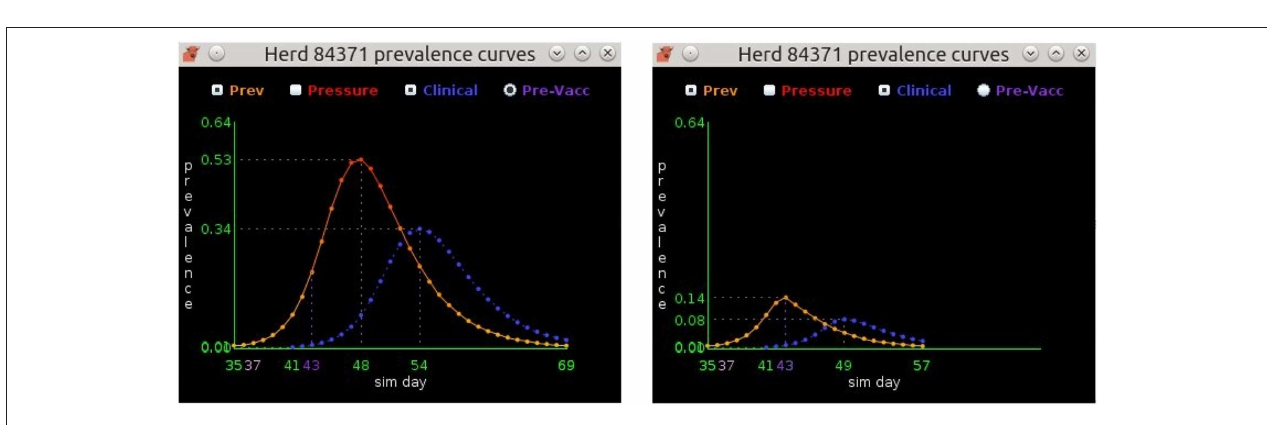
herd, but with vaccination occurring on day 37. Susceptible animals in the herd achieve immunity on day 43 resulting in a greatly diminished peak prevalence of 14% and an earlier end to infection on day